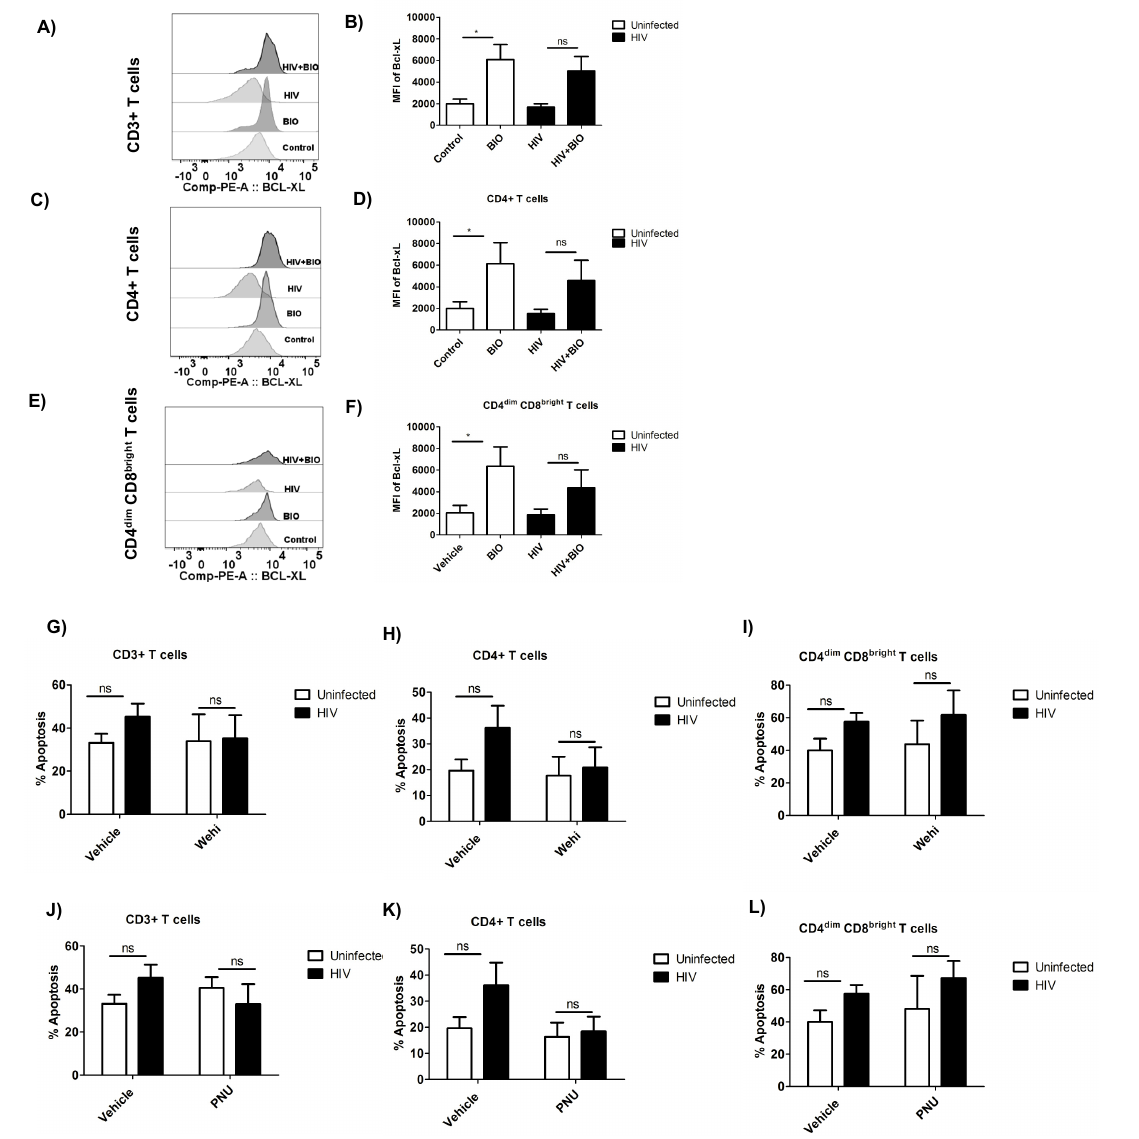
Figure 3. β -catenin protects CD4+ and CD4 dim CD8 bright T cells from HIV-induced apoptosis through the induction of Bcl-xL. PBMCs were cultured in complete RPMI and activated for 3 days with anti CD3/CD28 antibodies in the presence of 30 U/mL IL-2, then infected with HIV Bal , or left uninfected, for 6 h and washed. Cells 24 h post infection were treated with BIO or DMSO. Mean fluorescence intensity (MFI) of Bcl-xL was measured on day 6 post infection in CD3, CD4+, and CD4 dim CD8 bright T cells. ( A , C , E ) Representative flow histograms of MFI of Bcl-xL in CD3+, CD4+, and CD4 dim CD8 bright T cells, respectively. ( B , D , F ) Cumulative data of Bcl-xL MFI, as measured on day 6 post infection in CD3, CD4+, and CD4 dim CD8 bright T cells. n = 5 per group. Data are represented as mean ± SEM and analyzed using one-way ANOVA and Newman–Keuls multiple comparisons test. * means p ≤ 0.05. ( G – L ) PNU-7465 and WEHI-539 do not contribute to apoptosis . Three-day-activated PBMCs were infected with HIV Bal for 6 h, or left uninfected, and washed. Twenty-four hours post infection, cells were treated with PNU-74654 (50 µM) or WEHI-539 (5 µM) or proper vehicle control; 6 days post infection, apoptosis was measured using flow cytometry. Cumulative data of mean percentage of total apoptosis in CD3+, CD4+, and CD4 dim CD8 bright T cell populations were represented. n = 4 per treatment. Data are represented as mean ± SEM and analyzed using one-way ANOVA and Newman–Keuls multiple comparisons test. * means p ≤ 0.05. ns denotes no